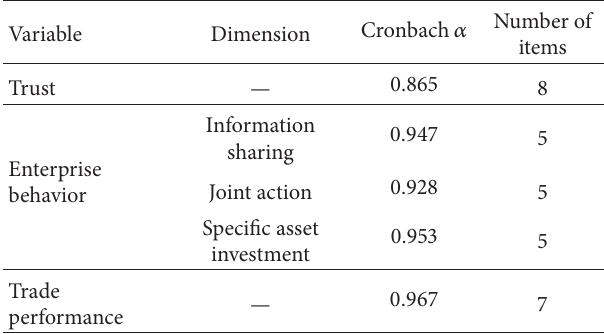
Table 9: The Cronbach 𝛼 of the